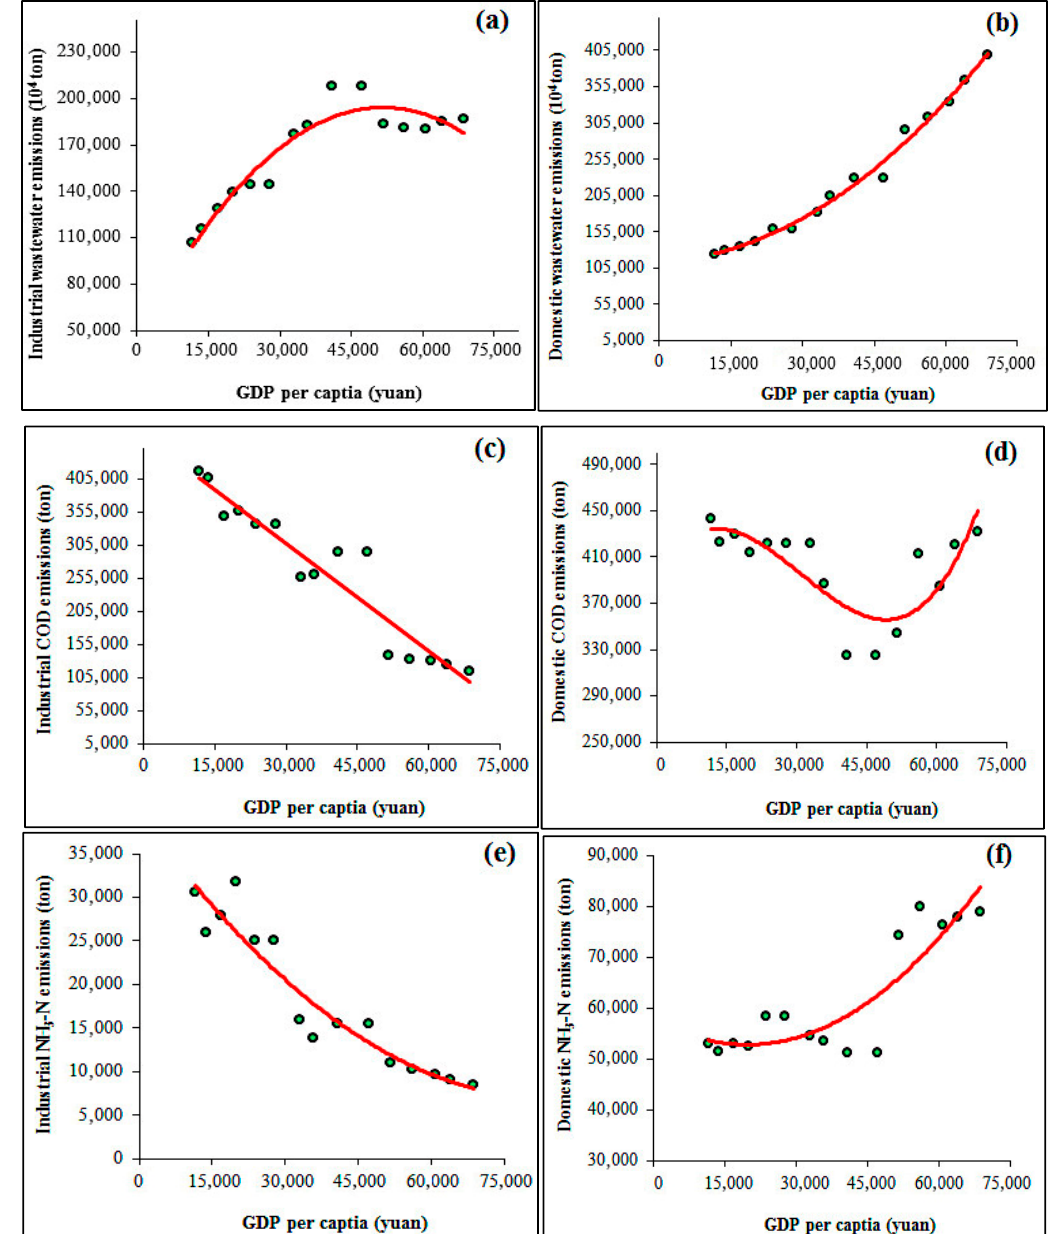
Figure 6. The EKC of industrial pollutant emissions and economic growth ( a ), of domestic wastewater emissions and economic growth ( b ), of industrial COD emissions and economic growth ( c ), of domestic COD emissions and economic growth ( d ), of industrial NH 3 -N emissions and economic growth ( e ), of domestic NH 3 -N emissions and economic growth ( f ).